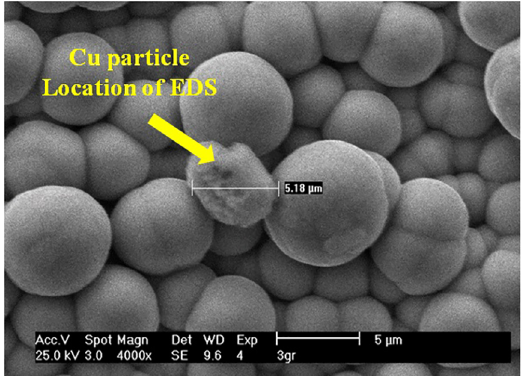
Figure 4. SEM micrograph of the Ni-P-3 gr/lit coating. The location of the EDS analysis is pointed out by arrow. Table 10. The amount of different elements in the Ni-P-3 gr/lit coating. Element